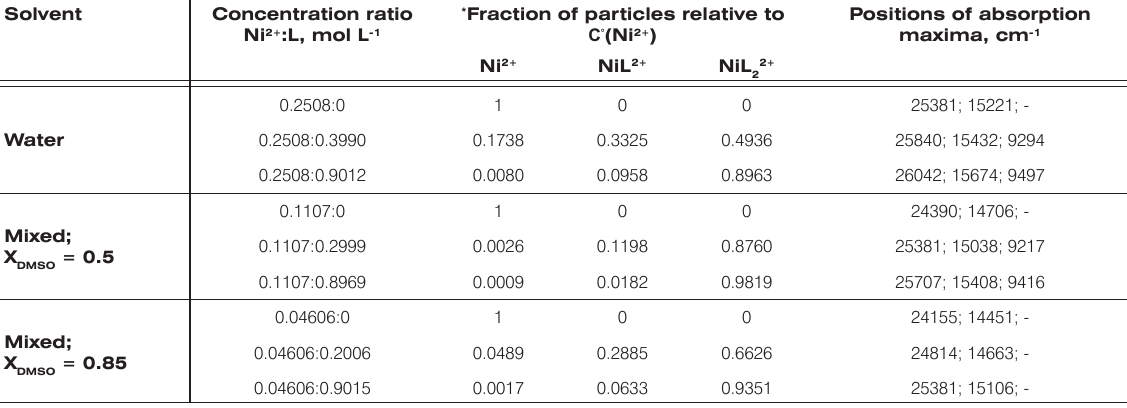
Table 2. Wavenumbers of electron transitions of nickel(II) complexes at different dimethyl sulfoxide and nicotinamide